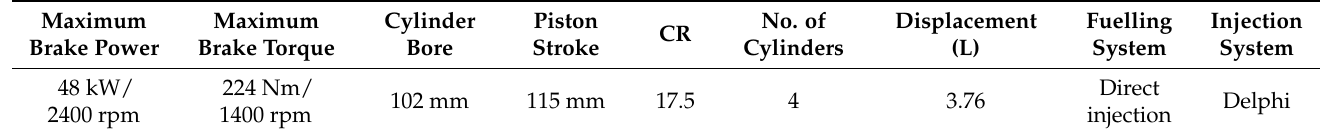
Table 1. Technical specifications of the diesel engine.